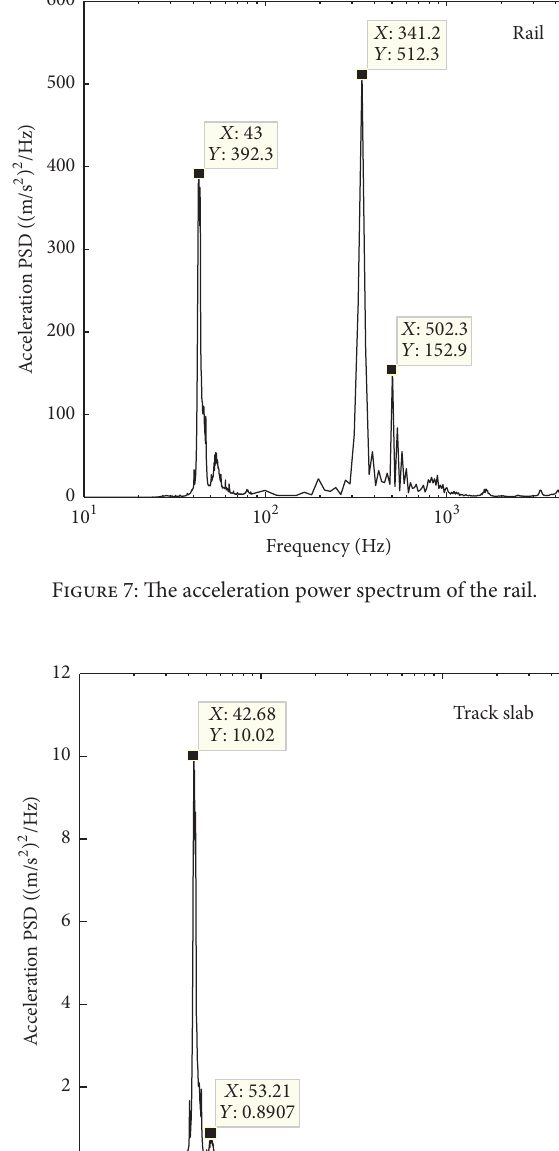
Figure 8: The acceleration power spectrum of the track slab.